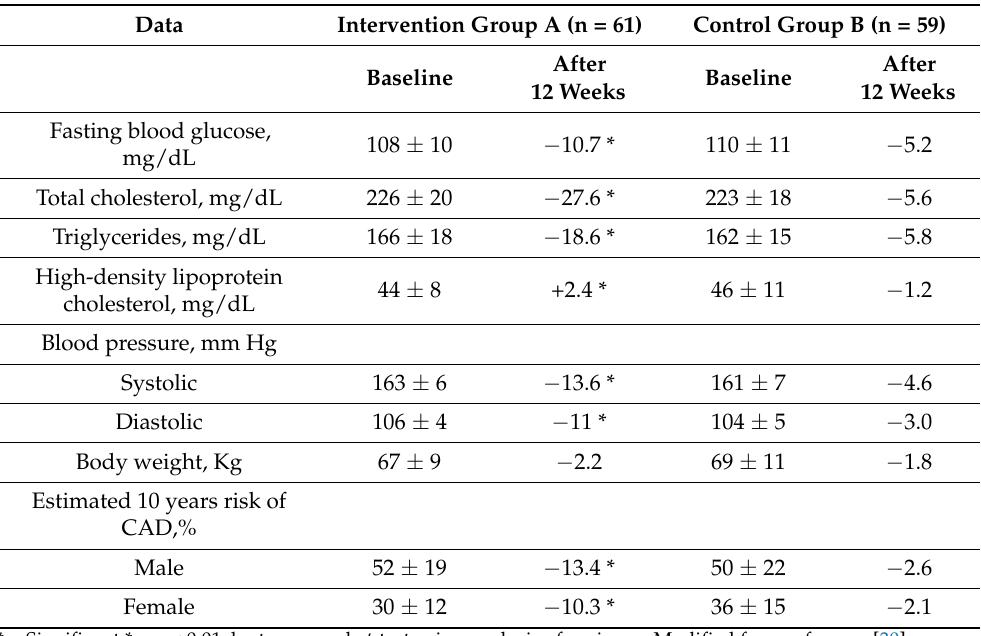
Table 4. Effects of guava fruit intake on blood glucose, blood pressure and blood lipids and estimated 10 year risk of coronary disease among patients with hypertension. Risk score is based on the Framingham score.